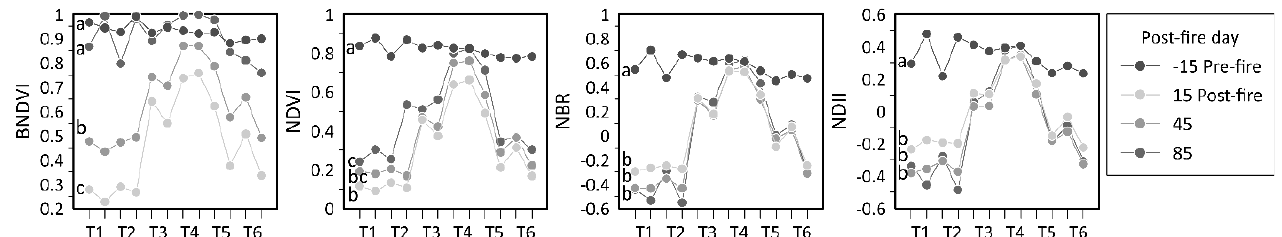
Figure 7. Reflectance indices calculated from Sentinel-2 data over 4 image dates from the Mesa Fire. Each transect has two data points, representing each endpoint. Transects T1–T2 are high-burn severity and T3–T6 are low/moderate severity. Blue Normalized Difference Index (BNDVI); Normalized Difference Vegetation Index (NDVI); Normalized Burn Ratio (NBR); Normalized Difference Infrared Index (NDII). Different lowercase letters on each plot indicate significant differences between image dates at p < 0.05, as evaluated with the mixed model.